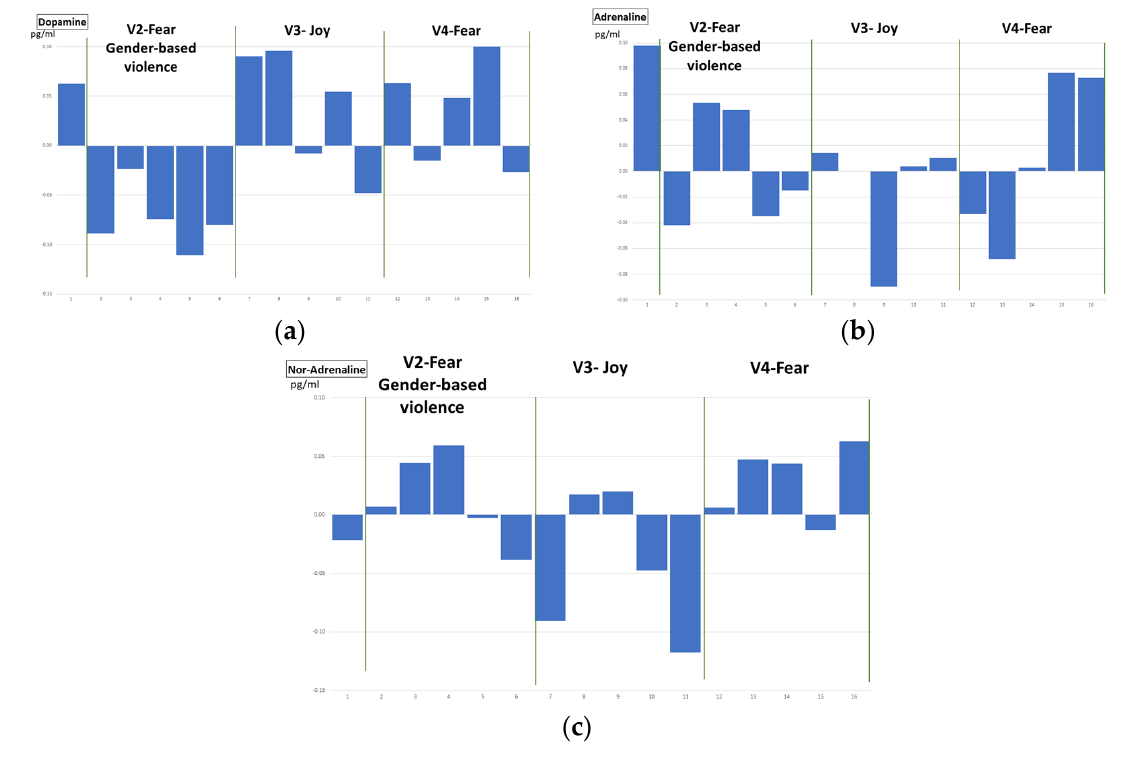
Figure 15. Temporal evolution of normalized concentrations for dopamine, adrenaline and nor- adrenaline ( a – c ) for every video clip, mean for all volunteers.